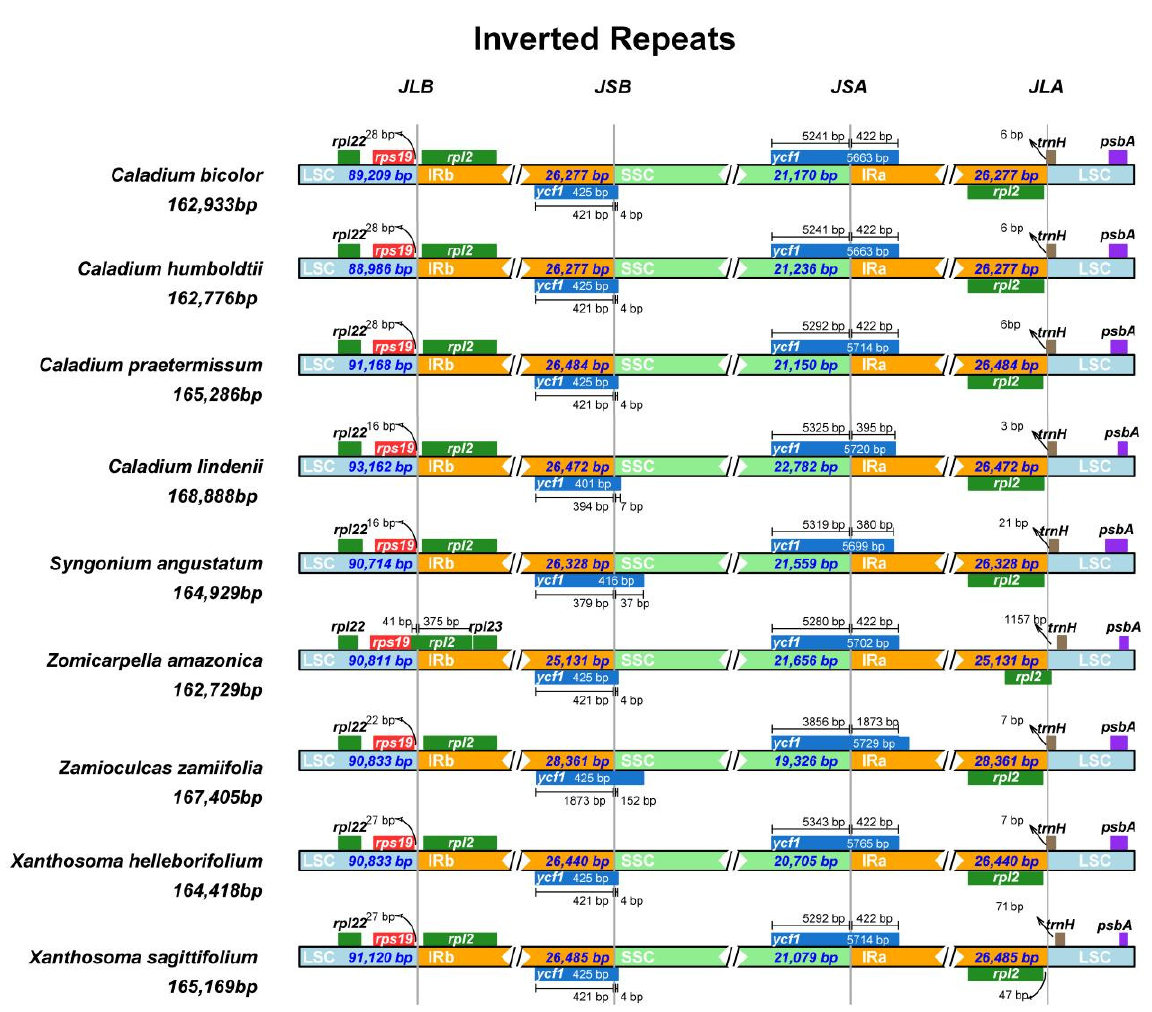
Figure 2. Comparison of the borders of the LSC, SSC, and IR regions of nine species of Araceae. The numbers above the gene features denote the distance between the gene borders, either the start or end of genes, and the junction sites.